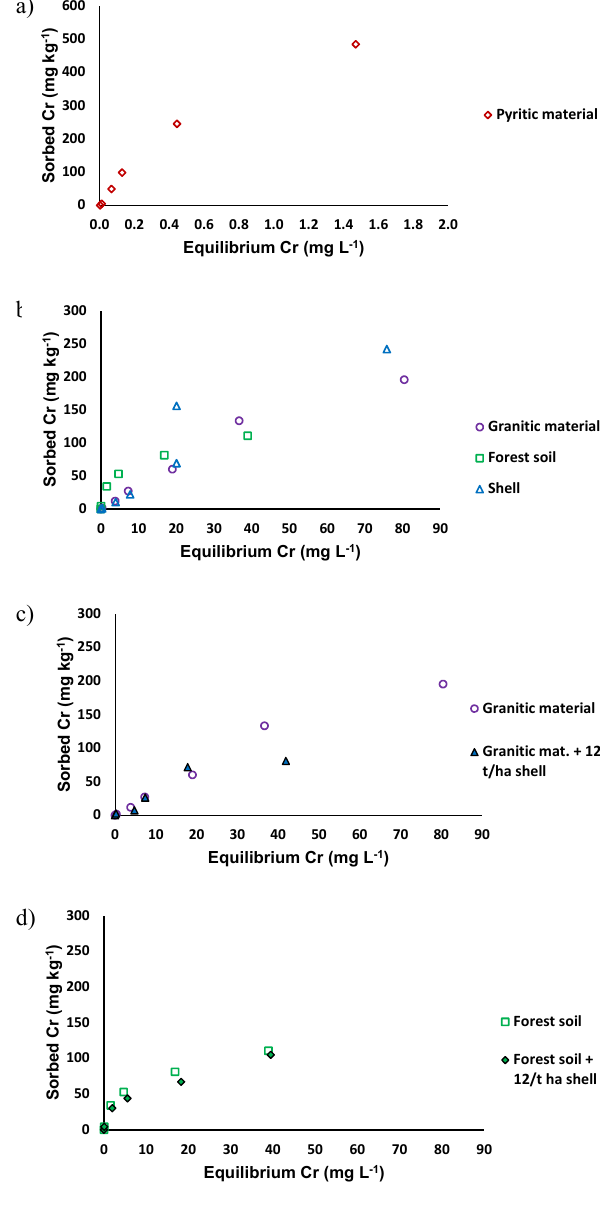
Figure 1. Sorption points corresponding to the pyritic material (a) ; granitic material, forest soil, and mussel shell (b) ; granitic material with or without mussel shell (c) ; and forest soil with or without mussel shell (d) . Mean values; triplicate samples with coefficient of variation <5%.